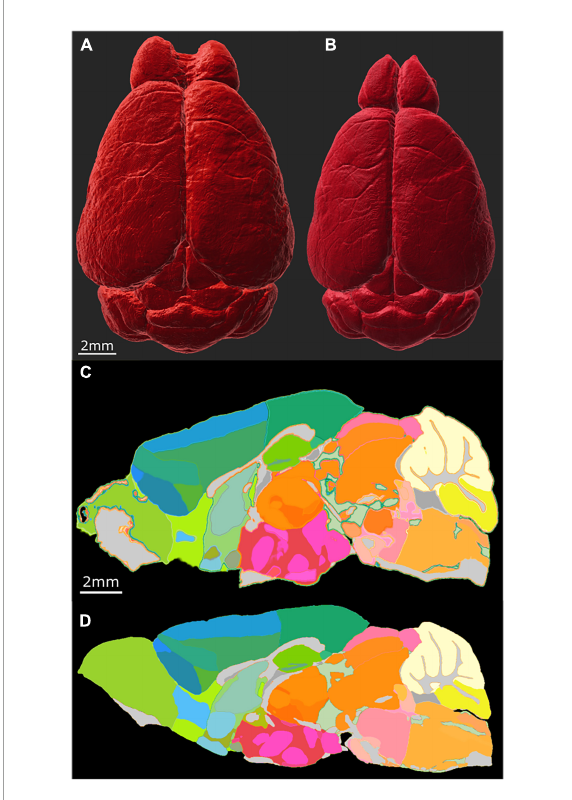
FIGURE5 Distortion correction of the LSM data by registration to the MRI of the same specimen (190108). (A) Surface rendering of uncorrected LSM volume and (B) corrected LSM volume. The scale bar is 2 mm. (C) Midsagittal section of the labels on the LSM data before correction; (D) midsagittal section after correction: the scale bar in panels (C,D) is 2 mm. The distortion is present both within the plane of section and across the plane making it difficult to define identical planes. The highlighted edges in panel (C) are an interpolation artifact.